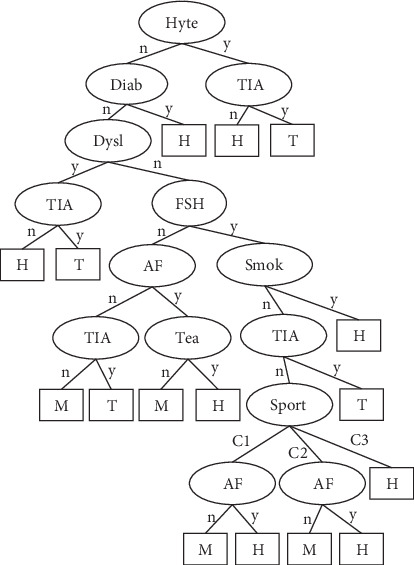
Decision tree #1 to classify risk factors of stroke.